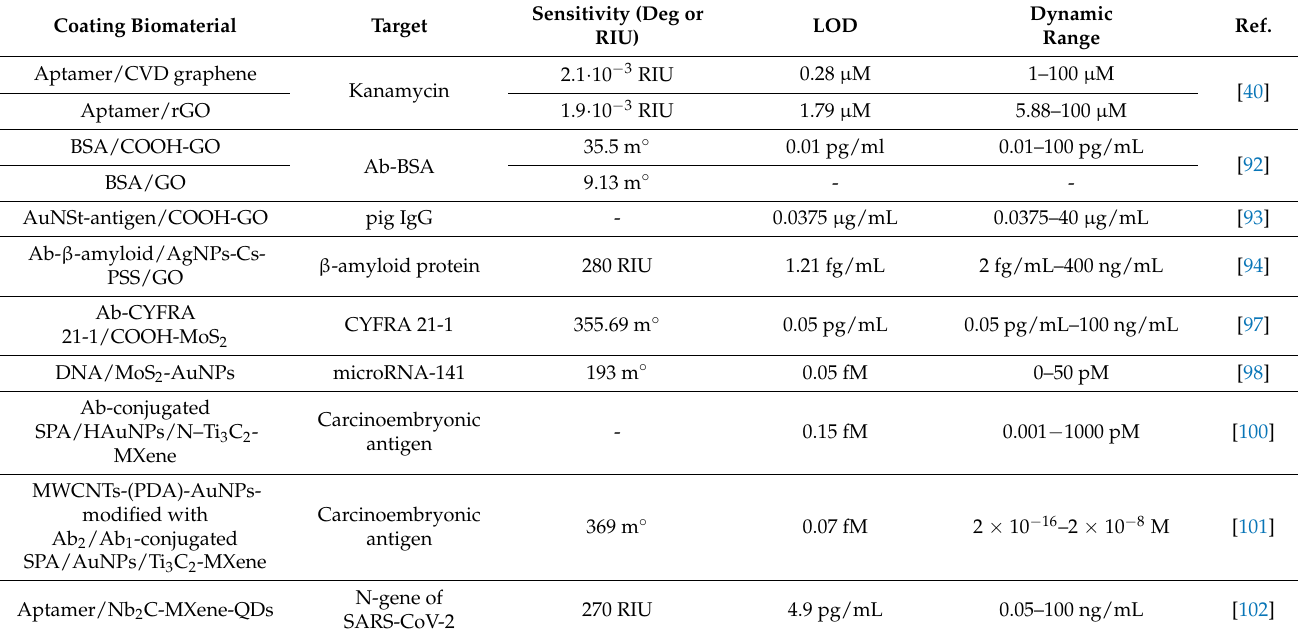
Table 1. Design and performance of 2D material multilayer SPR biosensors.